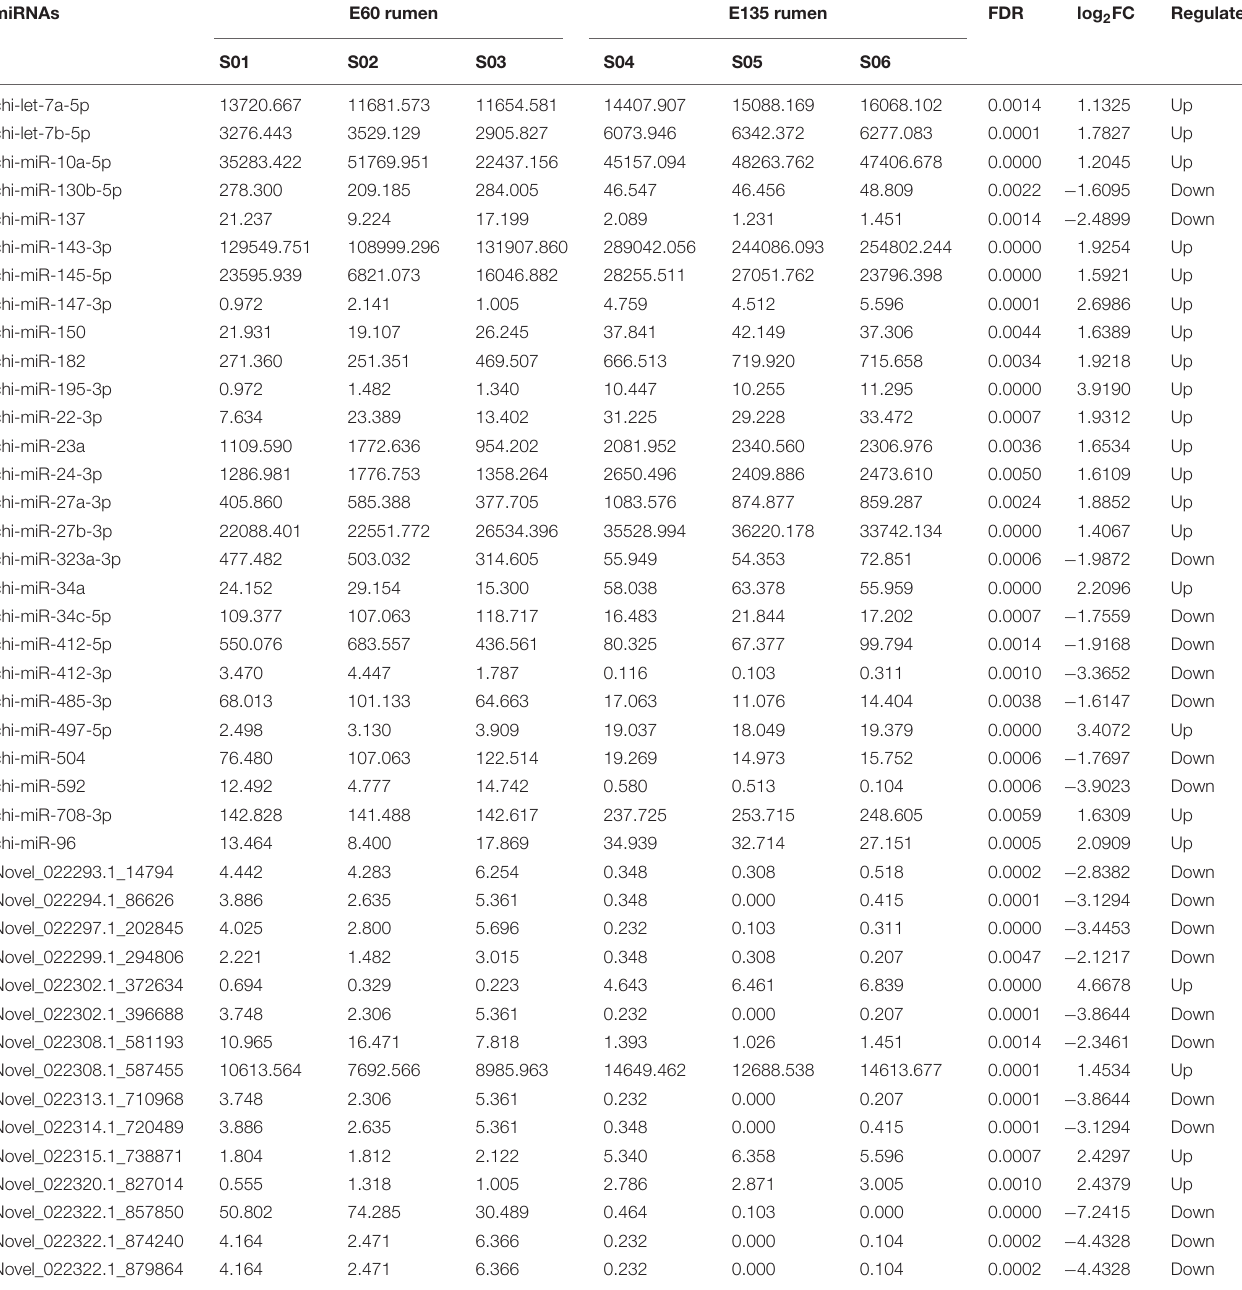
TABLE 2 | List of the differentially expressed miRNAs identified at E60 and E135 rumen tissues. miRNAs E60